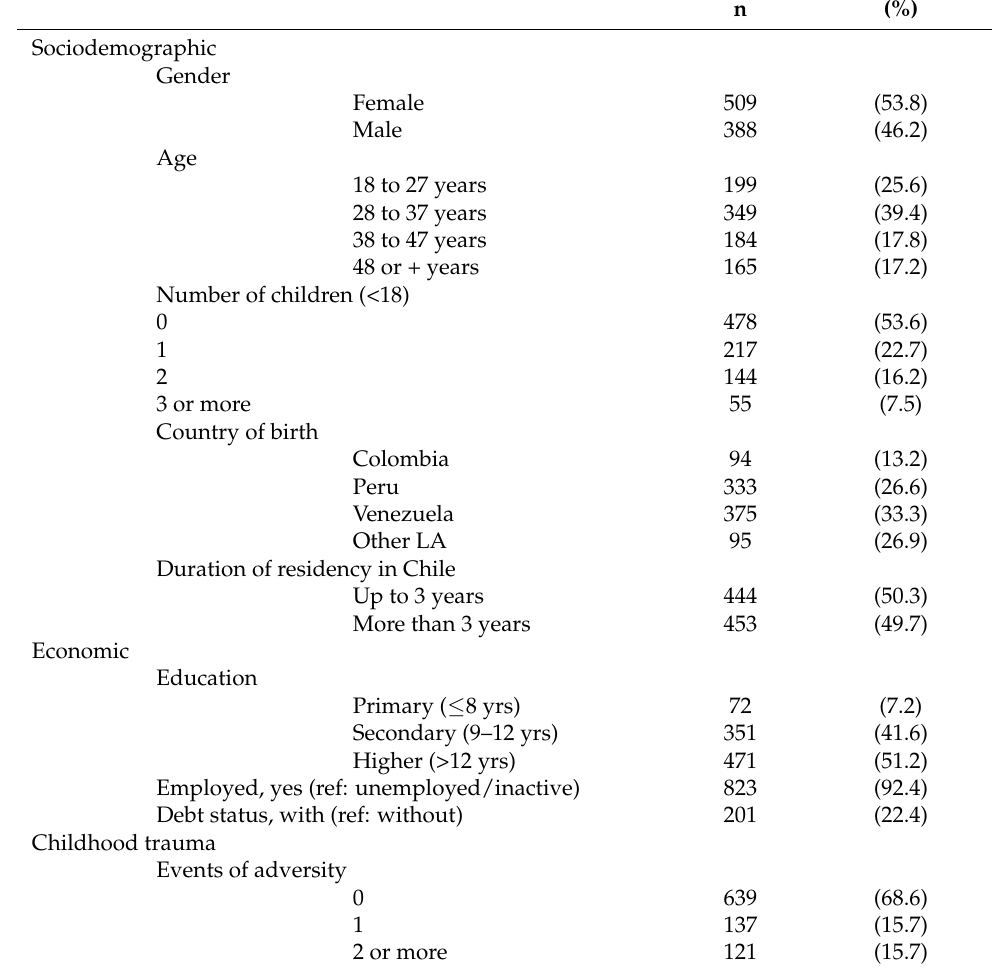
Table 1. Sociodemographic, economic, and childhood trauma characteristics of participants (n = 897).